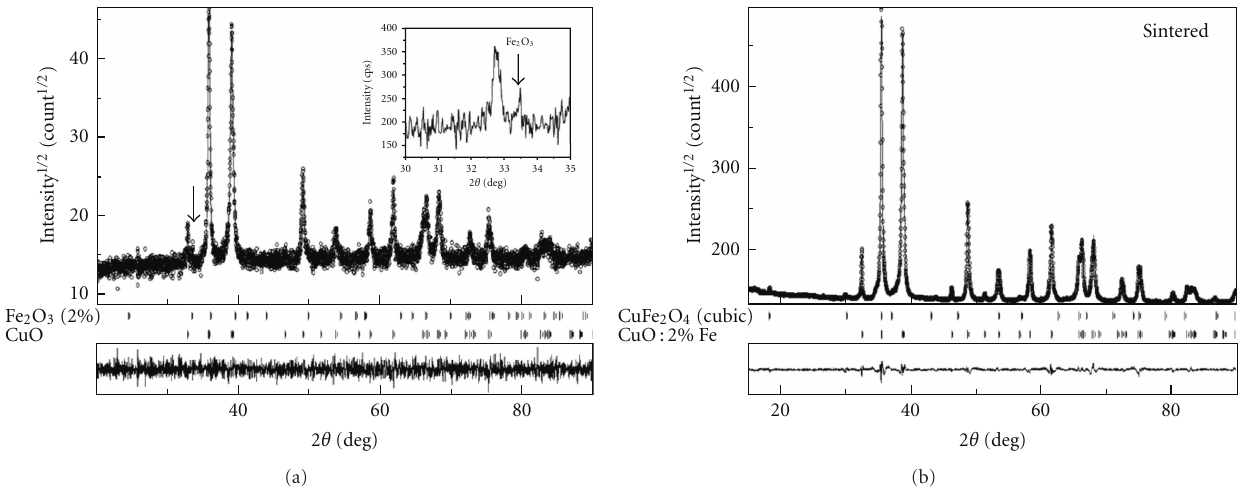
Figure 2: Rietveld refinement of the XRD patterns of as-mixed CuO :Fe 2 O 3 (2%) (a) and that sintered at 900 ◦ C/12h in air (b). The open circles indicate the observed pattern, and the overlying continuous line represents the calculated pattern. The vertical lines indicate the peak position of the respective phases. The bottom continuous line of each pattern represents the di ff erence between the observed and calculated (Obs-Cal) patterns.